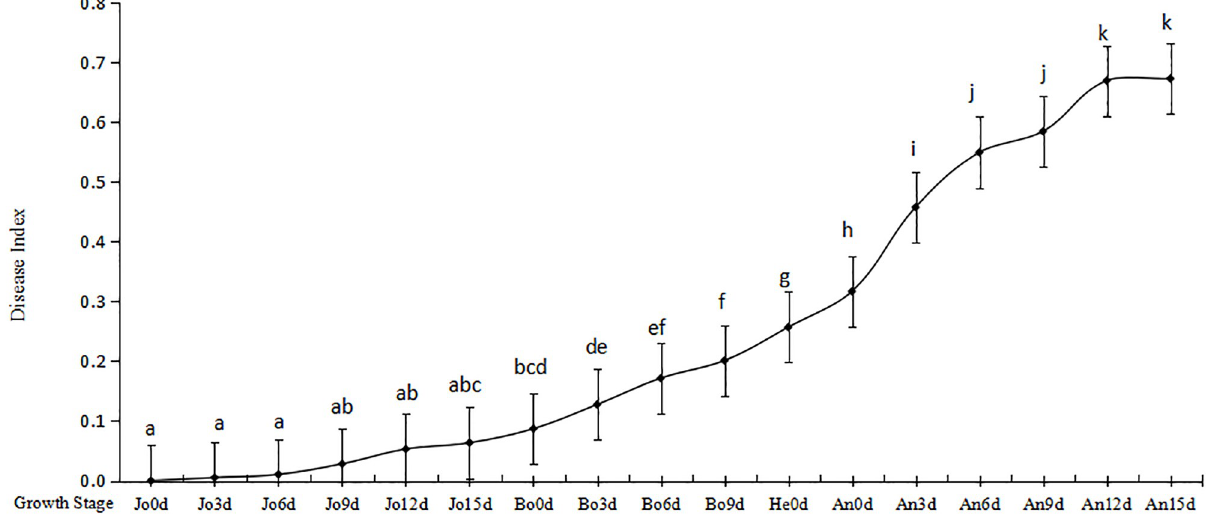
Fig 2. Dynamic of disease index. Note: The letters of the dynamic line means there were significant differences at the level of 0.05.